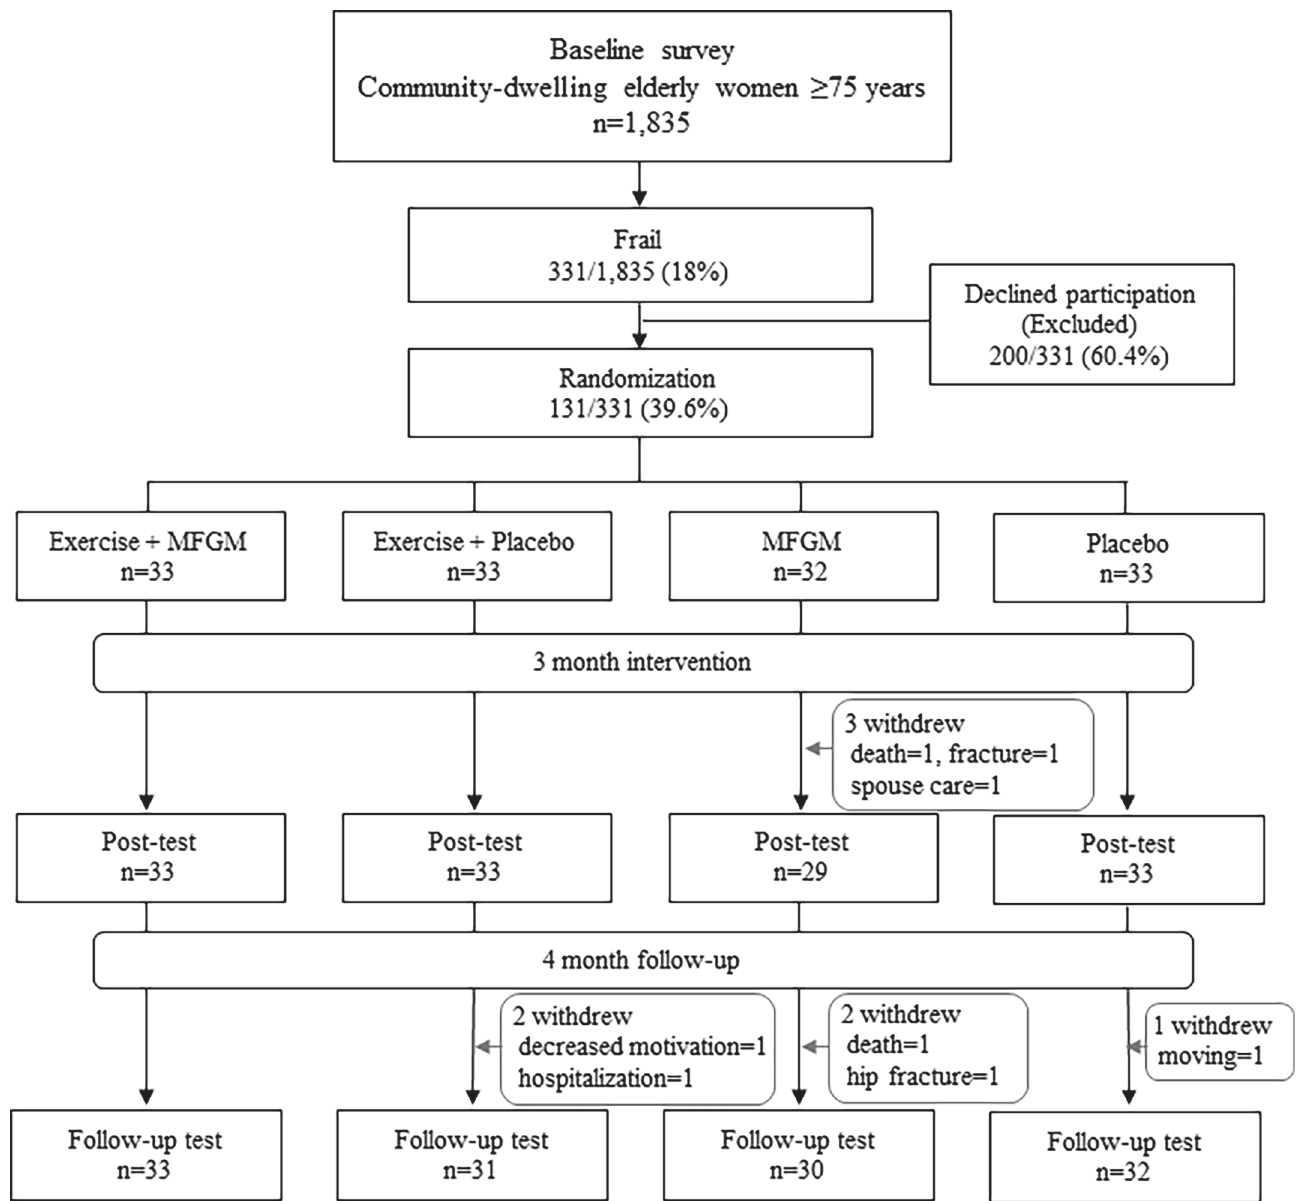
Fig 1. Flow chart of participant recruitment during the randomized controlled trial of exercise and/or nutrition